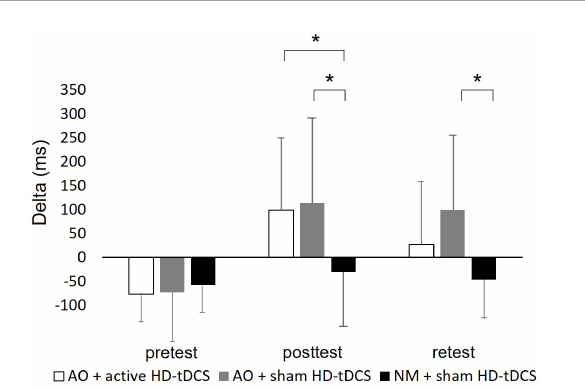
FIGURE5 Mean of reaching time of each group displayed by time. Ms, millisecond; AO, action observation; HD-tDCS, high-definition transcranial direct stimulation. Error bars show the standard deviation. Asterisks denote a significant difference.